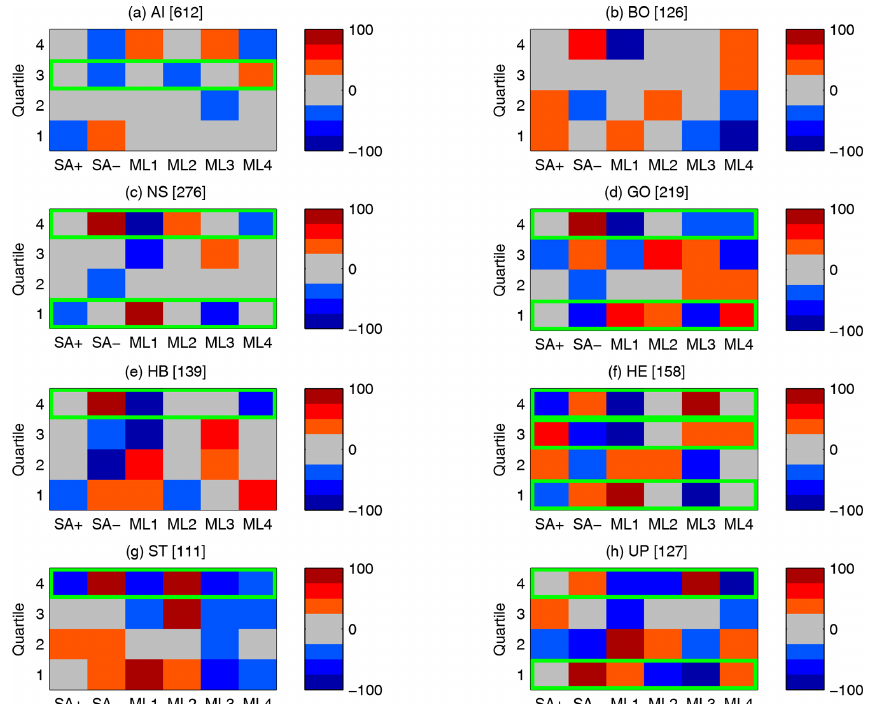
Figure 11. Environment-to-circulation characterisation: CAMS WR frequency anomaly for each quartile of the AOD anomalies at 500nm at the AERONET stations. Values represent percentage changes relative to climatological frequencies. Green boxes highlight significant changes in the WR frequencies, i.e. frequency anomalies exceeding the critical threshold (11.07) for the chi-square statistics with 5 degrees of freedom at the 95% level of confidence (chi-square statistics are reported in Table S6). In brackets, the number of available daily observations are indicated.